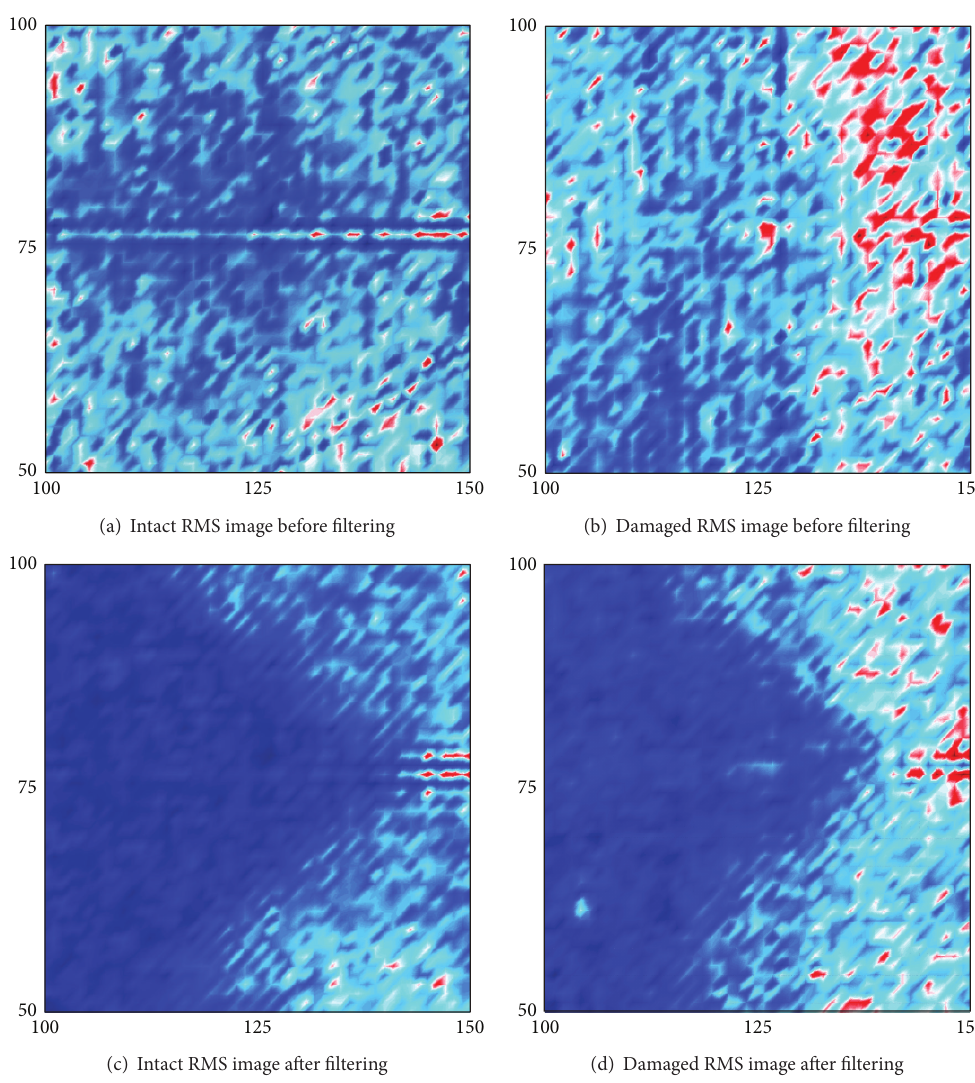
Figure 18: Comparison of RMS snapshots at 155 𝜇 s for damage case